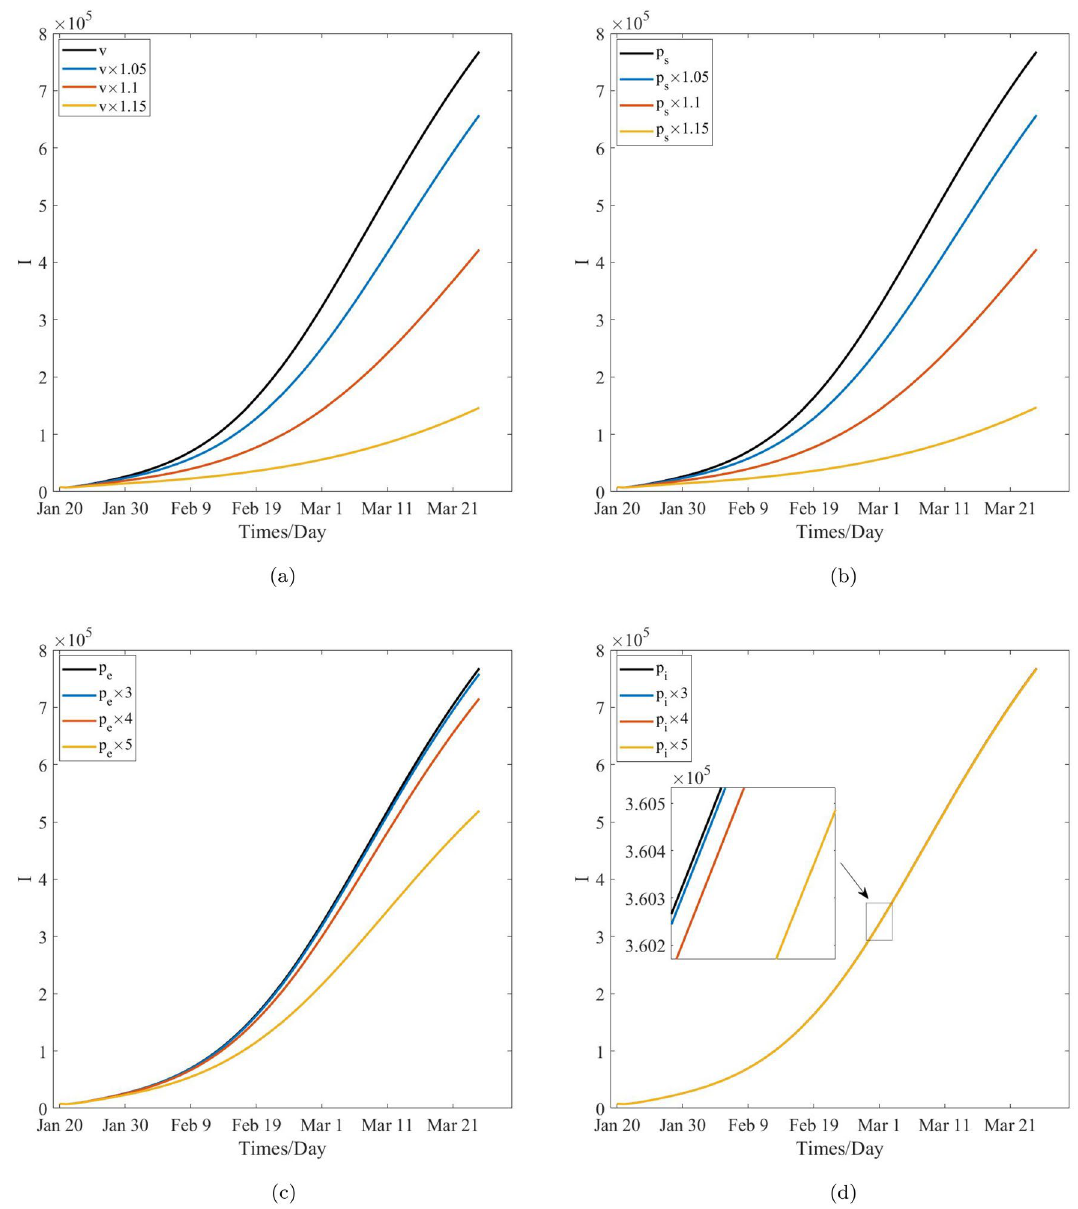
Figure 11. The effect of the critical parameters v , p s , p e and p i on newly confirmed